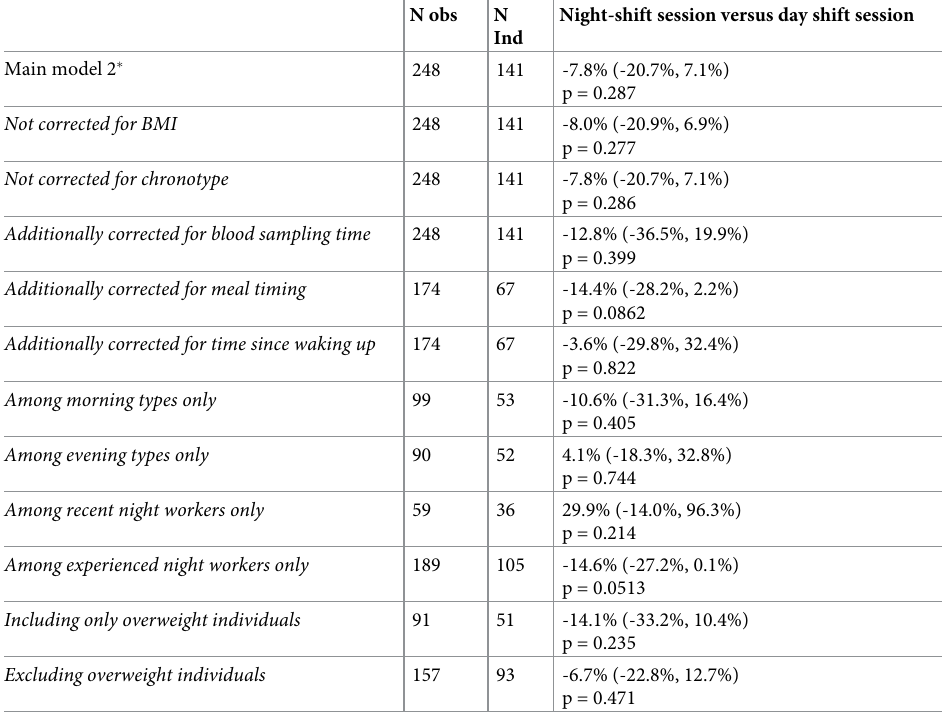
Table 3. Percentage difference in sCD36 concentrations between samples collected during a night-shift session and samples collected during a day-shift session among night-shift workers. N obs N